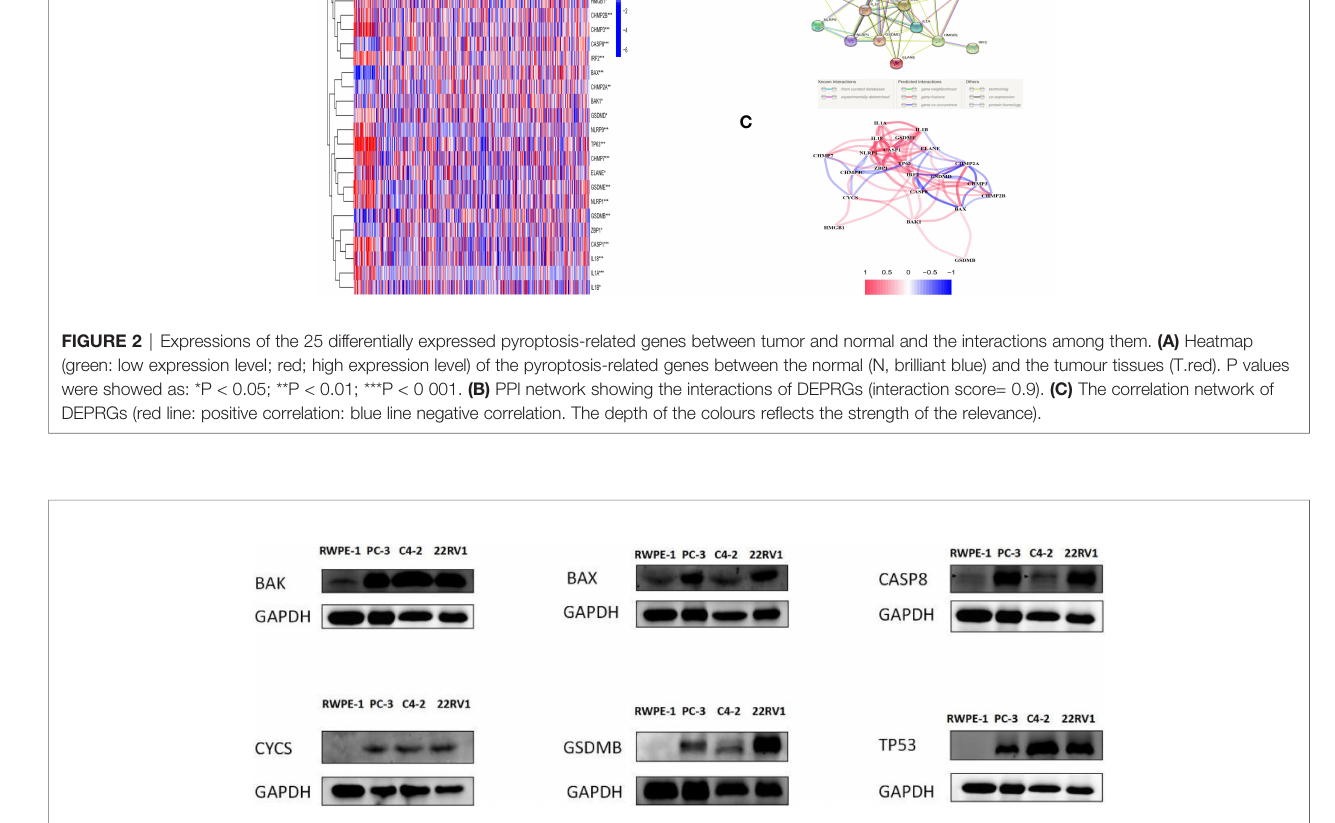
FIGURE 3 | WESTERN-BLOT validation of hub DE-PRGs expressions in normal and tumor tissues, the results showed that protein expression levels of CASP8, BAK, BAX, CYCS, TP53, and GSDMB genes were highly expressed in three CRPC (Castration Resistant Prostate Cancer) cell lines compared to the control normal cell line (RWPE- I ). CRPC cell lines (PC-3, C4-2, 22RVI), Control cell line (normal human prostatic epithelial cell,